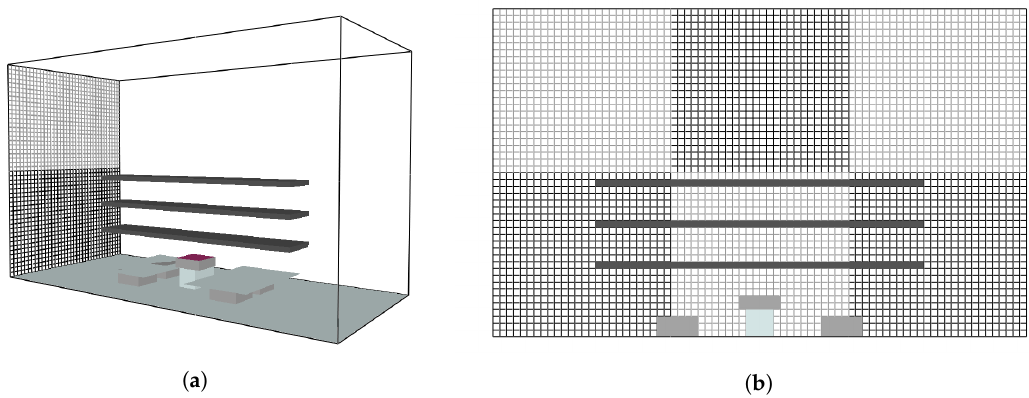
Figure 2. Geometrical representation of the MT3 simulation setup in Smokeview. ( a ) Perspective view. ( b ) Layout of six meshes for the MT3 simulations, indicated by different grey-scale colouring of the meshes.